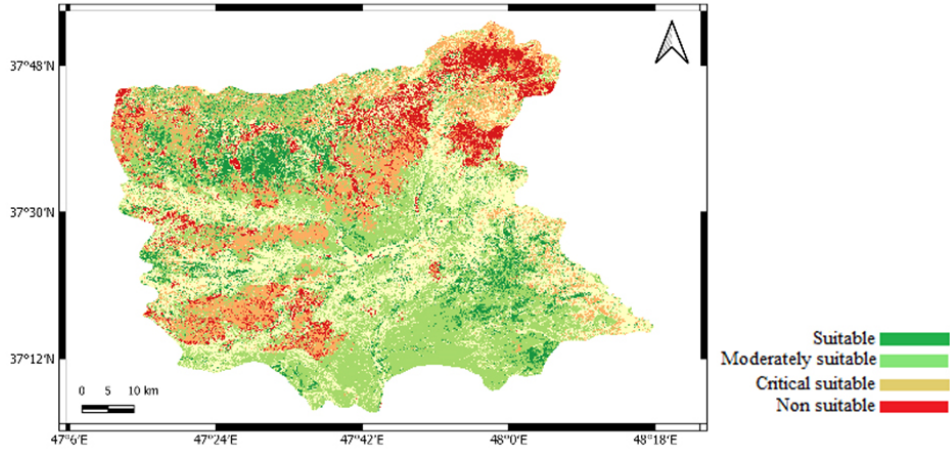
Figure 6. Final zoning map of the study area.